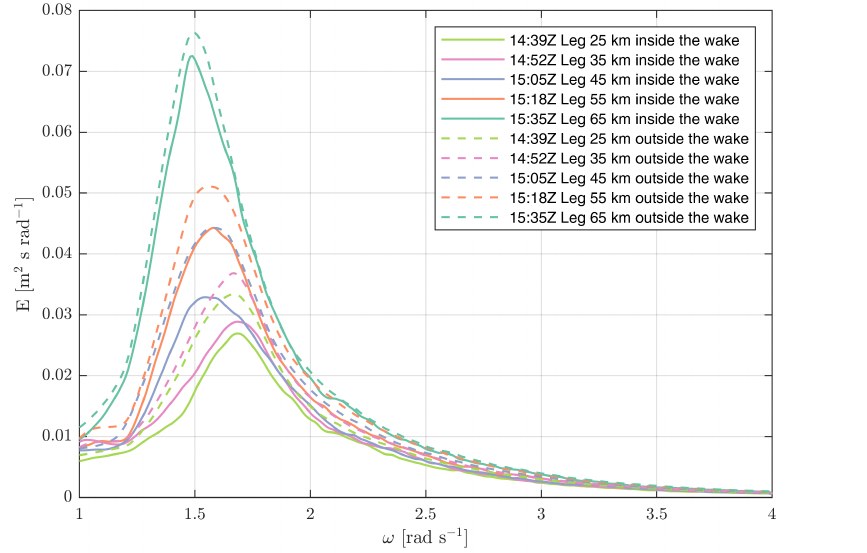
Figure 5. Variance density spectra inside and outside the wake. The general accordance with wave growth theory is evident, and a reduction of energy inside the wake is visible compared to the wave energy outside the wake in a relatively undisturbed area. The relative reduction in energy is shown in Figure 6.